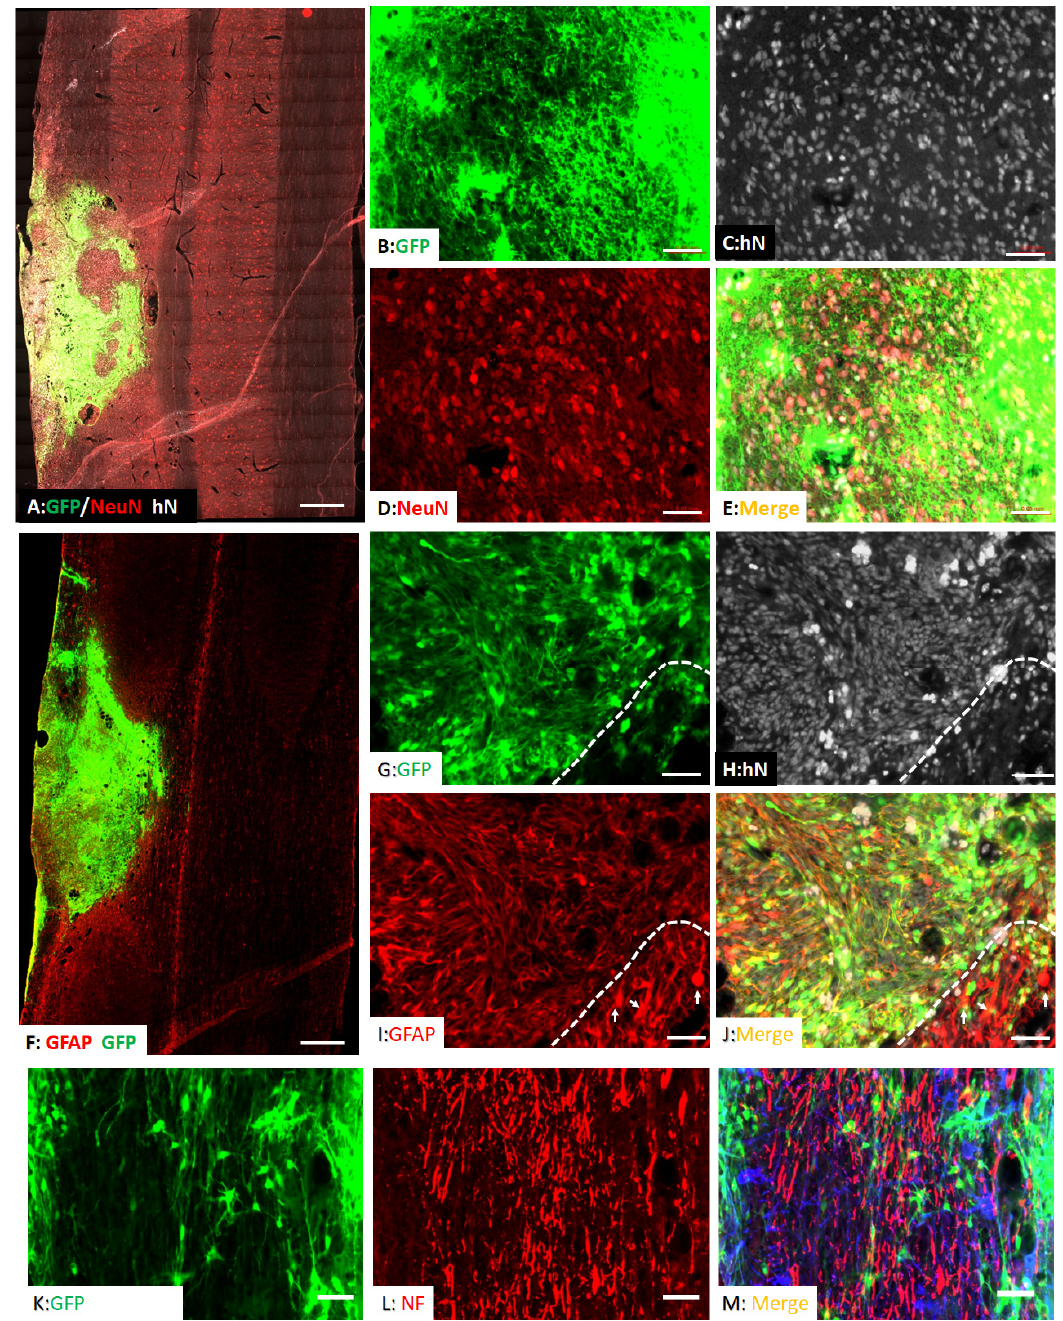
Figure 4. Differentiation of grafted hiPSC-derived NPCs after SCI. At 2 months after transplanta- tion, 29% of grafted hiPSC-NPCs differentiated into mature NeuN+ neurons in the injured epicenter, where the host neurons were lost ( A ). In high magnification ( B – E ), NeuN+ neurons in the injured areas also expressed GFP and human nuclei (hN), indicating these neurons are derived from grafted hiPSC-NPCs. 67% of grafted NPCs differentiated into GFAP+ astrocytes in the injured spinal cord at 2 months after transplantation ( F – J ). Different from the host hypertrophic reactive astrocytes in the scar border ( I , J , arrows, white lines indicate the edge of glial scar), the graft-derived astrocytes had stellate morphology with small cell bodies and relatively longer processes. The host axons integrated well with the grafted NPCs and extended into the graft ( K – M ). Scale bars: ( A , F ), 500 µ m; ( B – E , G – J , K – M ), 50 µ